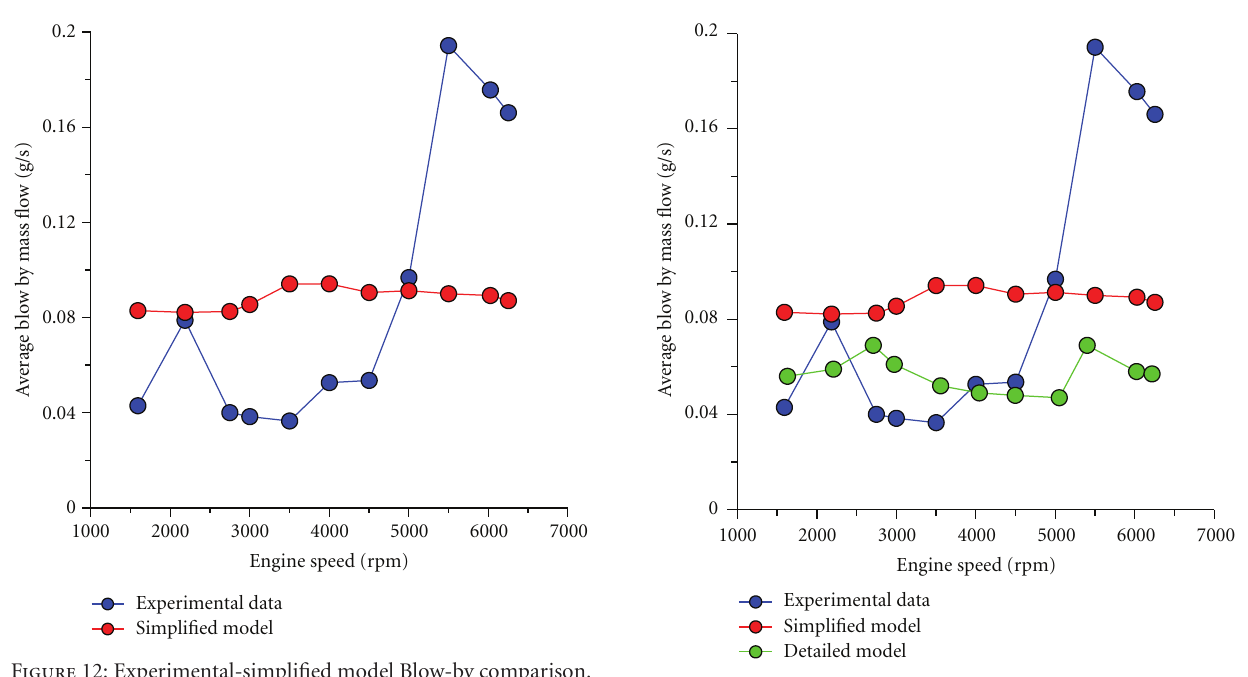
cross section, ports, or valves (automatic or controlled).